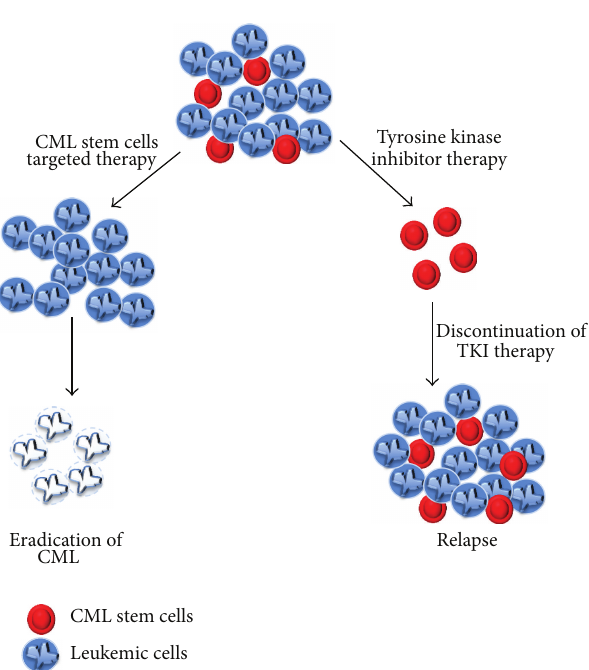
Figure 4: Schematic representation of CML stem cells response to